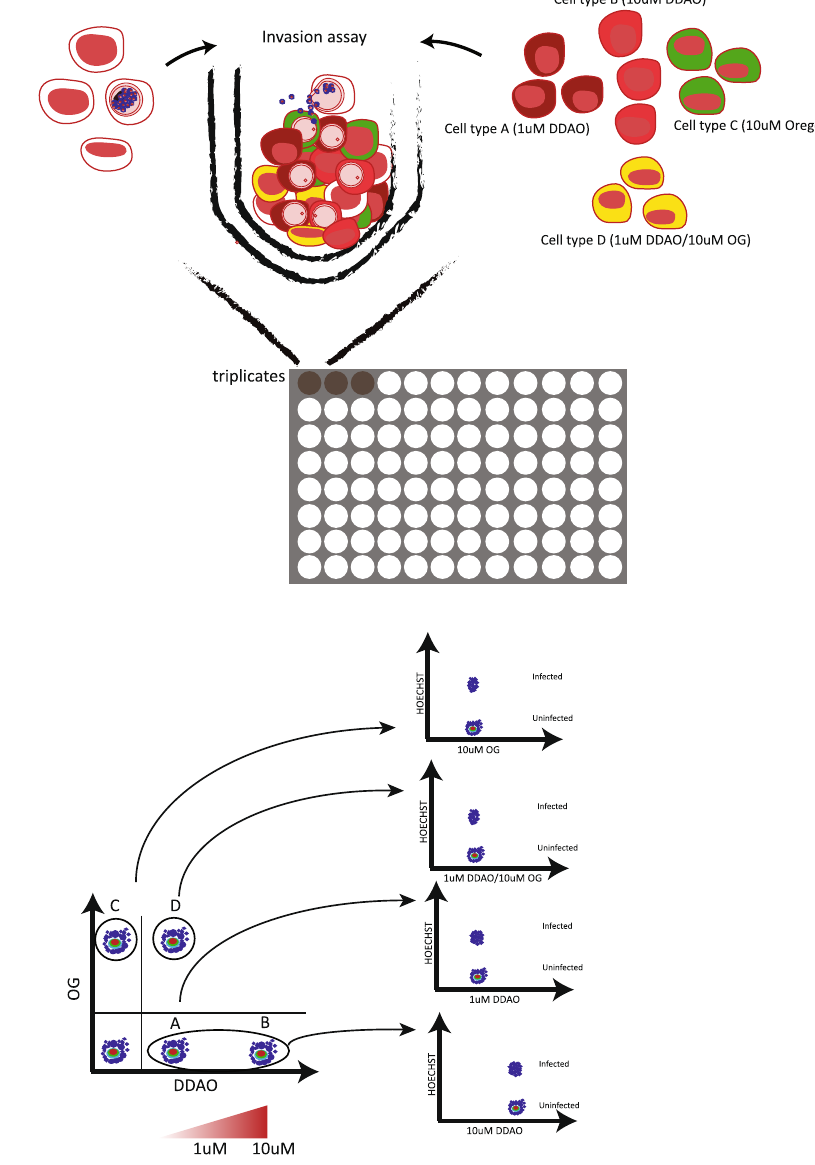
Figure 1. Design of a Plasmodium falciparum erythrocyte preference